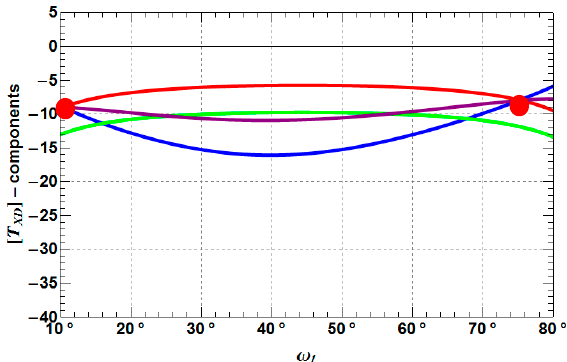
Figure 7. Sensitivity of coherency matrix elements T XD11 (blue), T XD12 (purple), T XD22 (red) and T XD33 (green) (dB) with local incidence angle ω l ( ε s = 20, ε t = 30, θ 1 = 30°, L SXD = 1, ϕ = 0°). Red points indicate the Brewster angle locations.